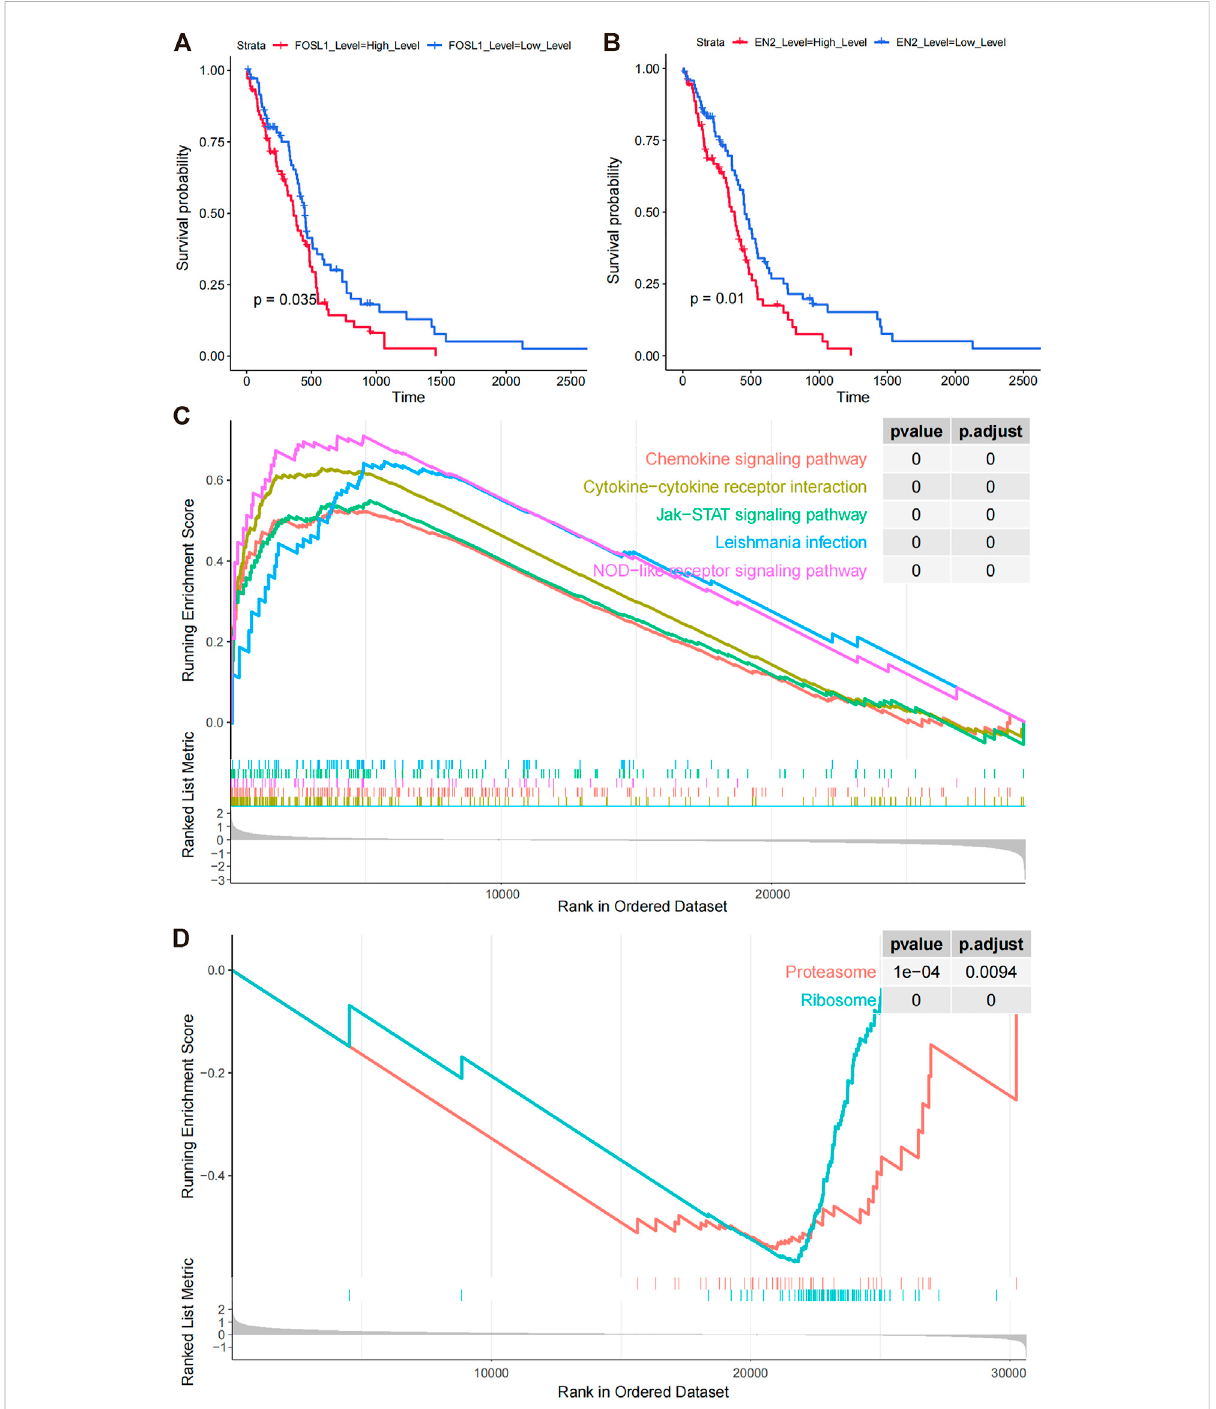
FIGURE 6 PrognosticmodelsignaturegenesanalyzedbyGSEA. (A,B) OverallsurvivaldifferencesamongFOSL1andEN2high-andlow-expressiongroups (grouped bymedian expression values). (C) GSEA enrichmentof KEGGpathways inFOSL1 high- andlow-groups. (D) GSEAsigni fi cantly enrichedthe KEGG pathway in the high- and low-EN2 expression